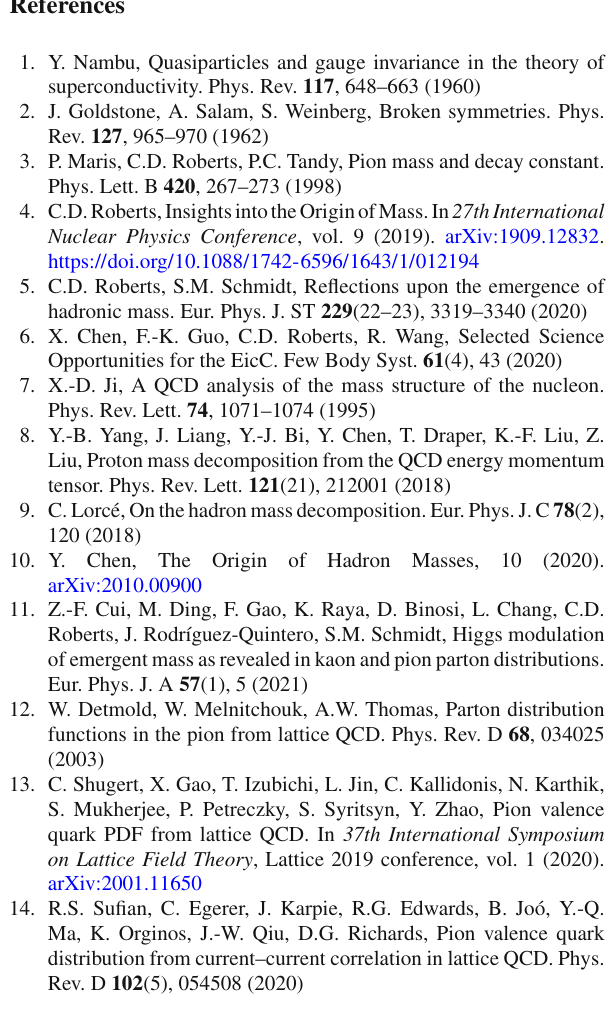
Fig. 12 Thecomparisonsoftheseaquarkdistributionsinsidethepion, the kaon, and the proton at Q 2 = 27 GeV 2 . The error bands of this work show the 3 σ uncertainties of the quantities